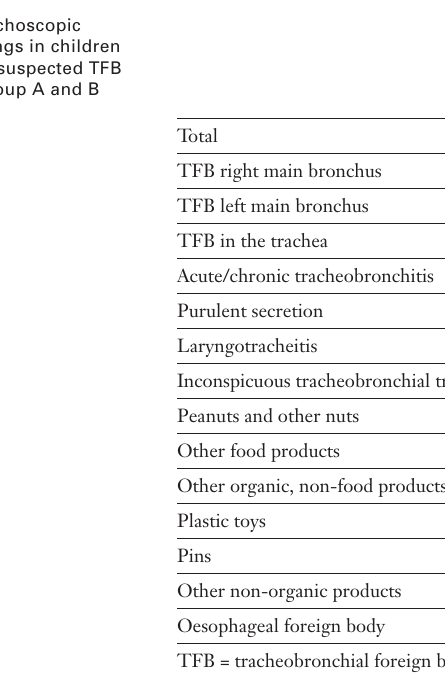
Table 3 Bronchoscopic findings in children with suspected TFB in group A and B